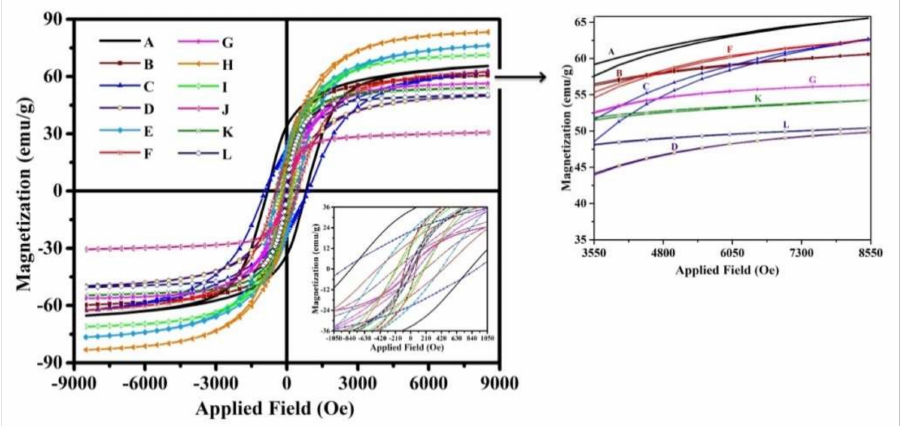
Figure 6. M-H loops of all synthesized nanoparticles at room temperature. Table 4. Magnetic properties of the synthesized